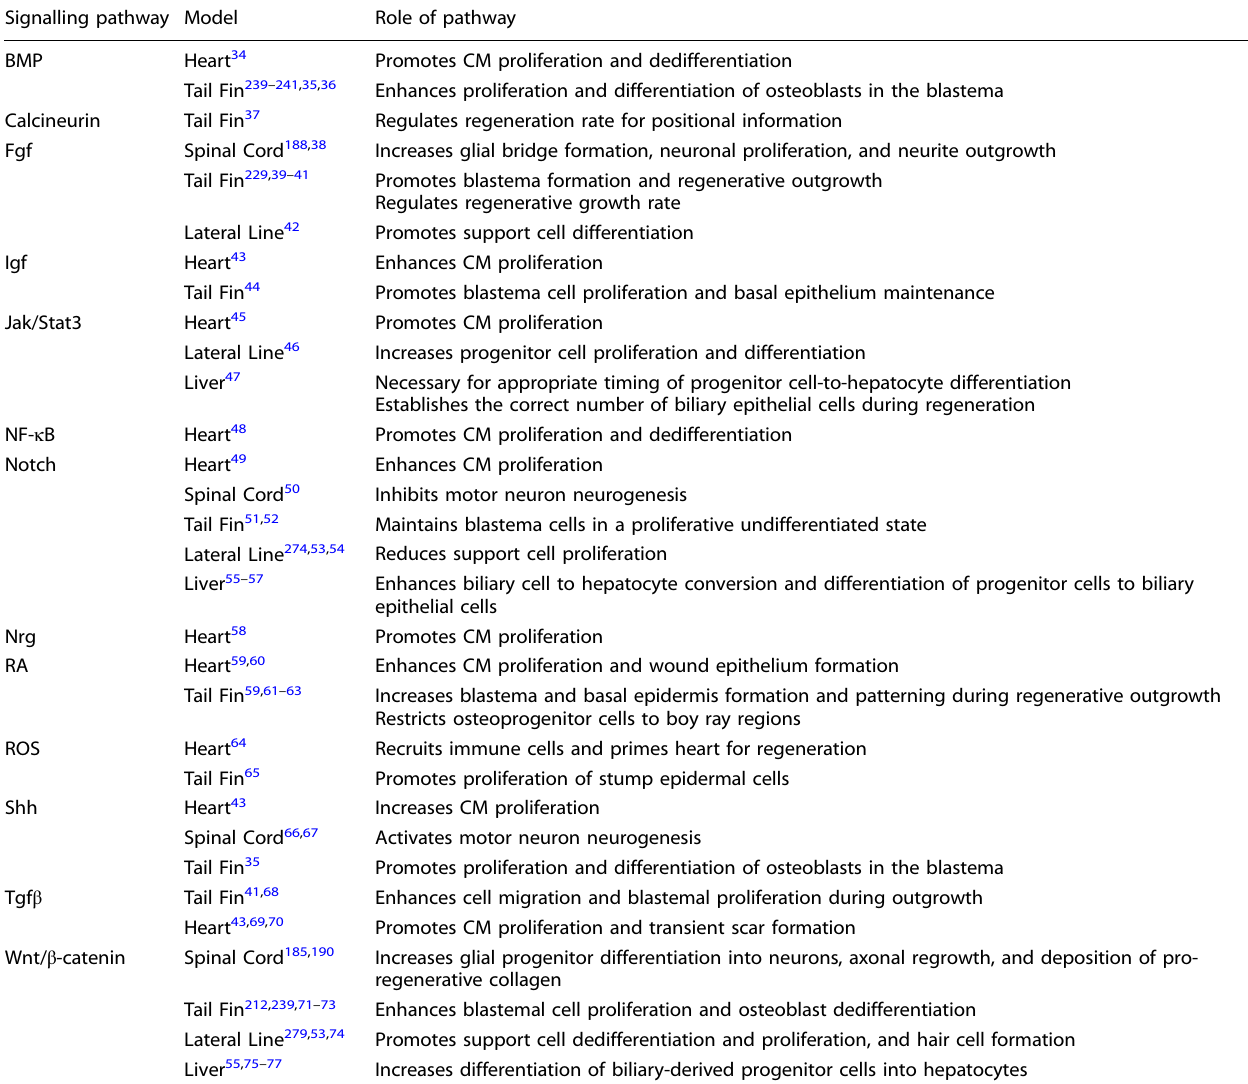
Table 1. A summary of major non-Hippo signalling pathways involved in zebra fi sh regeneration. Signalling pathway